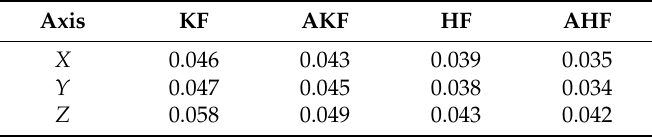
Figure 4. Position errors of the H-infinity filter (HF) algorithm. Table 1. Root mean square error (RMSE) values of the schemes